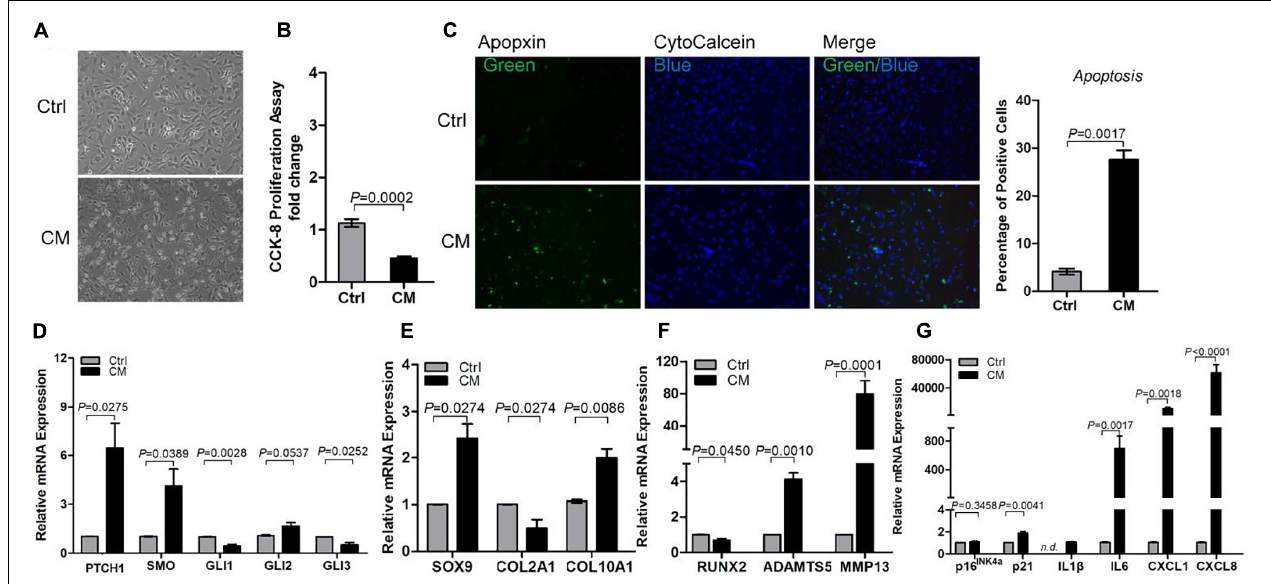
FIGURE 5 | Osteoarthritis mesenchymal stromal cell (OA-MSC)-derived conditioned medium (CM) stimulated chondrocyte apoptosis and expression of catabolic and senescence-associated secretory phenotype (SASP) genes in osteoarthritis (OA) chondrocytes. (A) Micrograph of osteoarthritic chondrocytes (OAC) shrunken cell morphology and detachment induced by OA-MSC-derived CM. (B) Inhibition of OAC cell proliferation by OA-MSC-derived CM. Cell proliferation rate was quantified by CCK-8 proliferation assay. (C) Fluorescence cytochemical analysis of chondrocyte apoptosis induced by OA-MSC-derived CM. OA chondrocytes were treated with OA-MSC CM at 37 ◦ C, 5% CO 2 for 24 h. Live chondrocytes were stained blue with Cytocalcein violet 450, while apoptotic cells were stained green with Apopxin green indicator. Scale bars = 125 µ m. Five individual images taken from three different human chondrocyte samples were assessed by Image J software and analyzed by two-tailed non-paired Students’ t- test. Real-time RT-PCR analysis of transcripts encoding markers of HH signaling (D) , chondrogenesis and hypertrophy (E) , catabolism (F) , and cell senescence and SASP (G) , in primary OAC treated with OA-MSC CM for 24 h. 18S RNA was used as a reference gene for RT-PCR amplification. p -values are indicated ( n = 3). Results are presented as mean ± S.E.M. from at least four independent